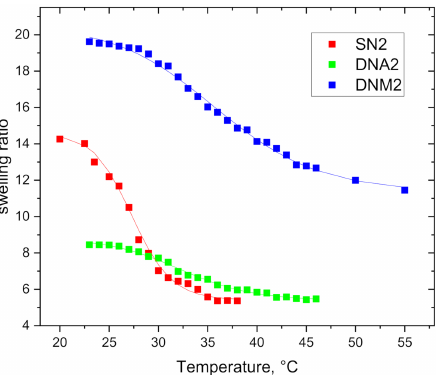
Figure 4. Temperature dependence of swelling ratio for hydrogels SN2, DNA2, and DNM2. Experimental points are fitted according to Equation (16).